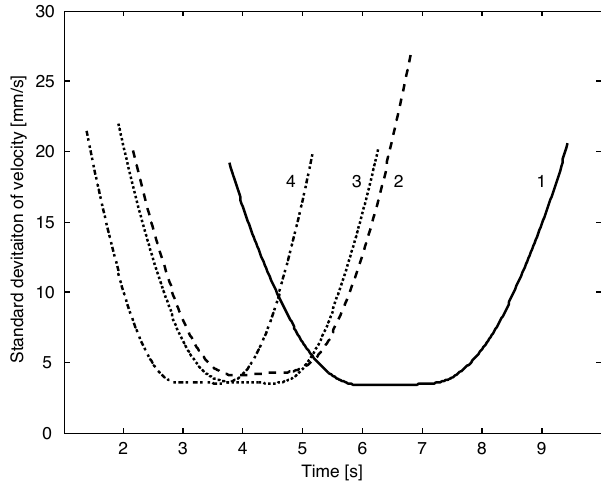
Fig. 5. Standard deviations of fitted velocities from the four beam passes. Numbers on the curves refer to the panels in Fig. 4.